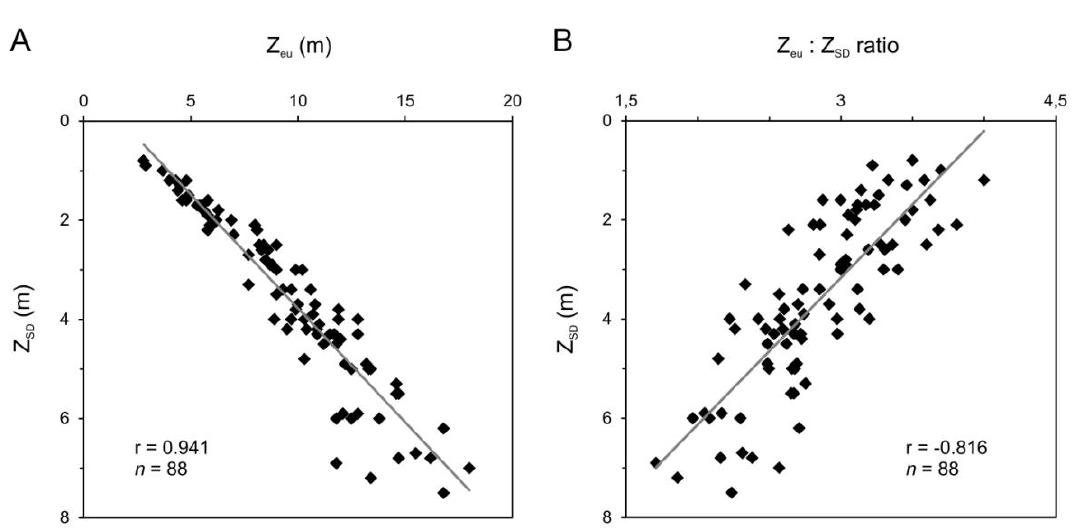
) and euphotic depth ( Z ); SD eu